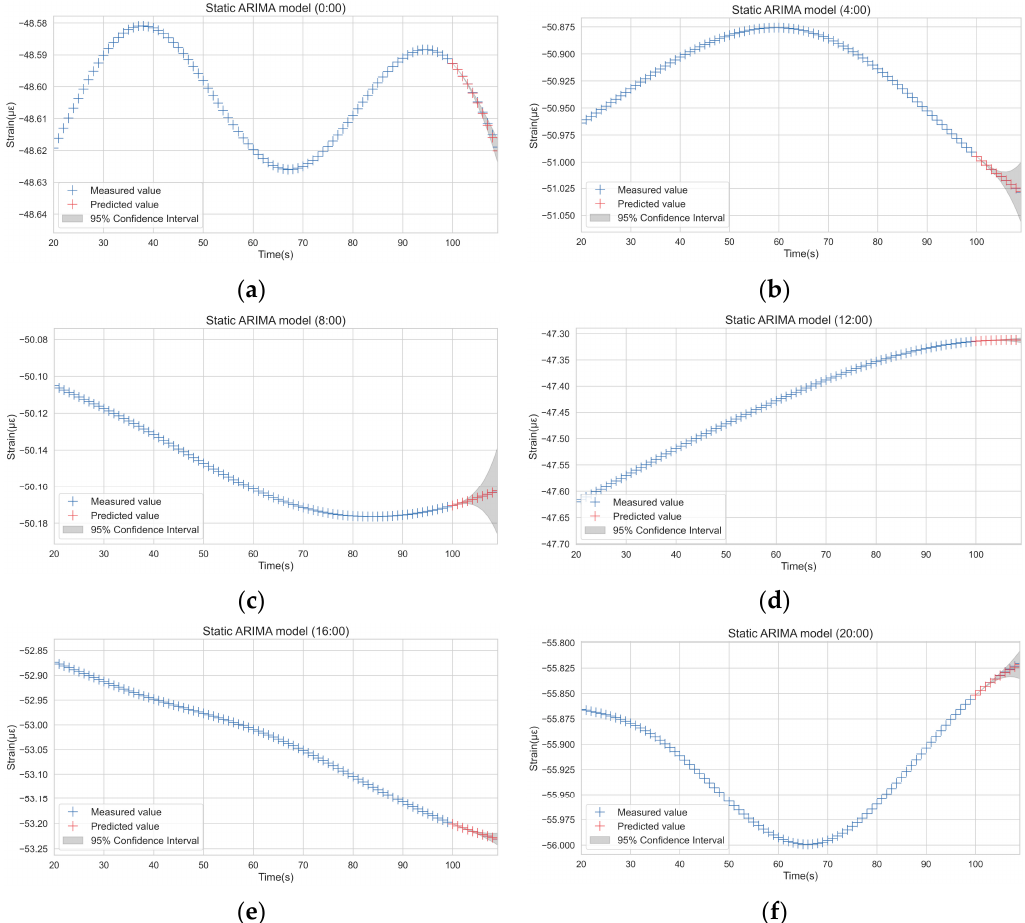
Figure 11. ARIMA prediction at different time periods: ( a ) Forecast results at 0:00; ( b ) Forecast results at 4:00; ( c ) Forecast results at 8:00; ( d ) Forecast results at 12:00; ( e ) Forecast results at 16:00; ( f ) Forecast results at 20:00.